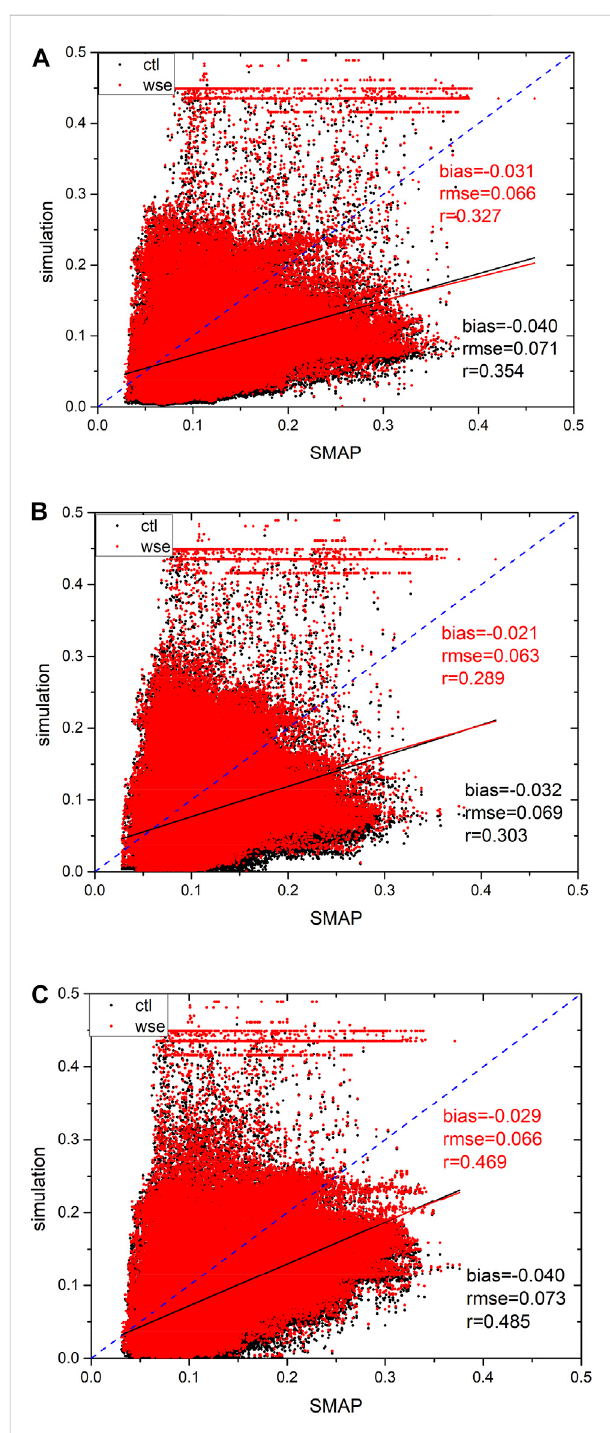
Scattered plots of the monthly average 10-cm-deep volumetric soil moisture from SMAP and IUM simulation. (ctl: control run; WSE: contrast run): (A) June, (B) July, (C)